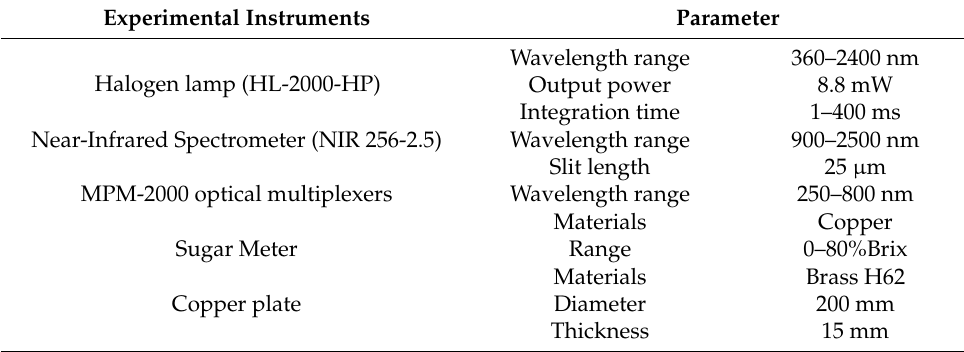
Table 7. The parameters of the experimental instruments.